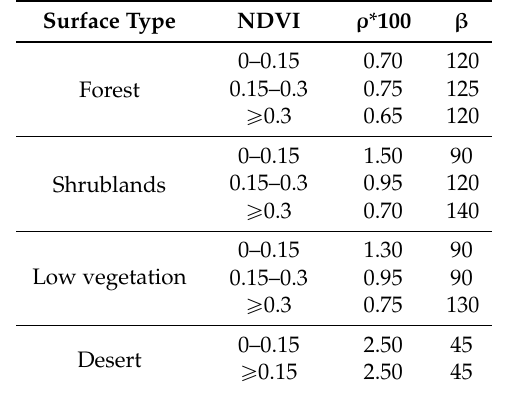
Table 2. Detailed parameters of the Nadal and Breon model [22]. ρ and β are empirical parameters that correspond to various surface types and NDVI